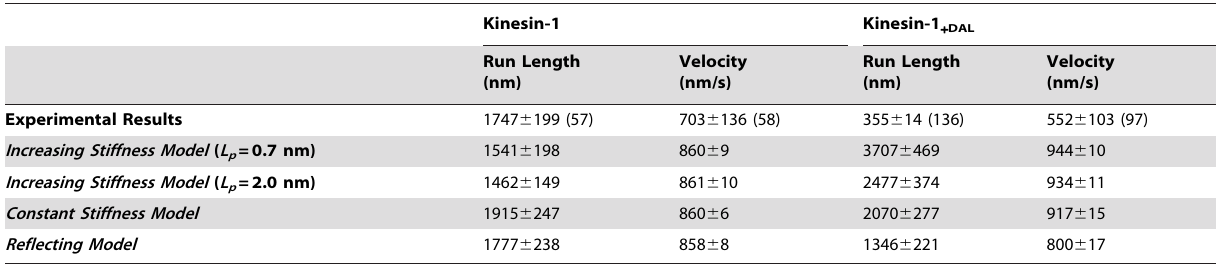
Table 2. Velocity and run length results.